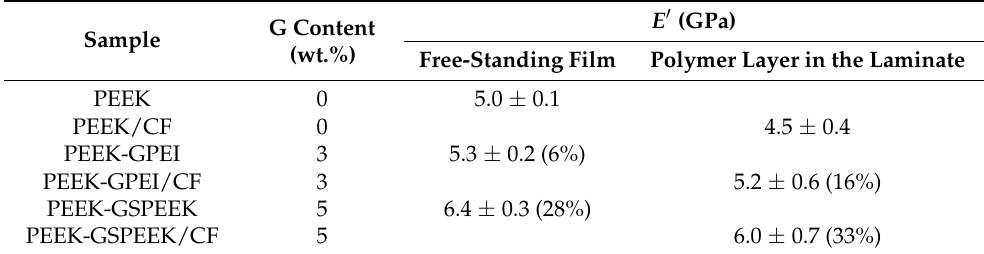
Table 2. Average indentation E’ values for the neat PEEK and PEEK-graphene materials in the form of free-standing films (PEEK, PEEK-GPEI, and PEEK-GSPEEK) or as part of the laminates, together with CF plies (PEEK/CF, PEEK-GPEI/CF, and PEEK-GSPEEK/CF). G Content Sample Sample